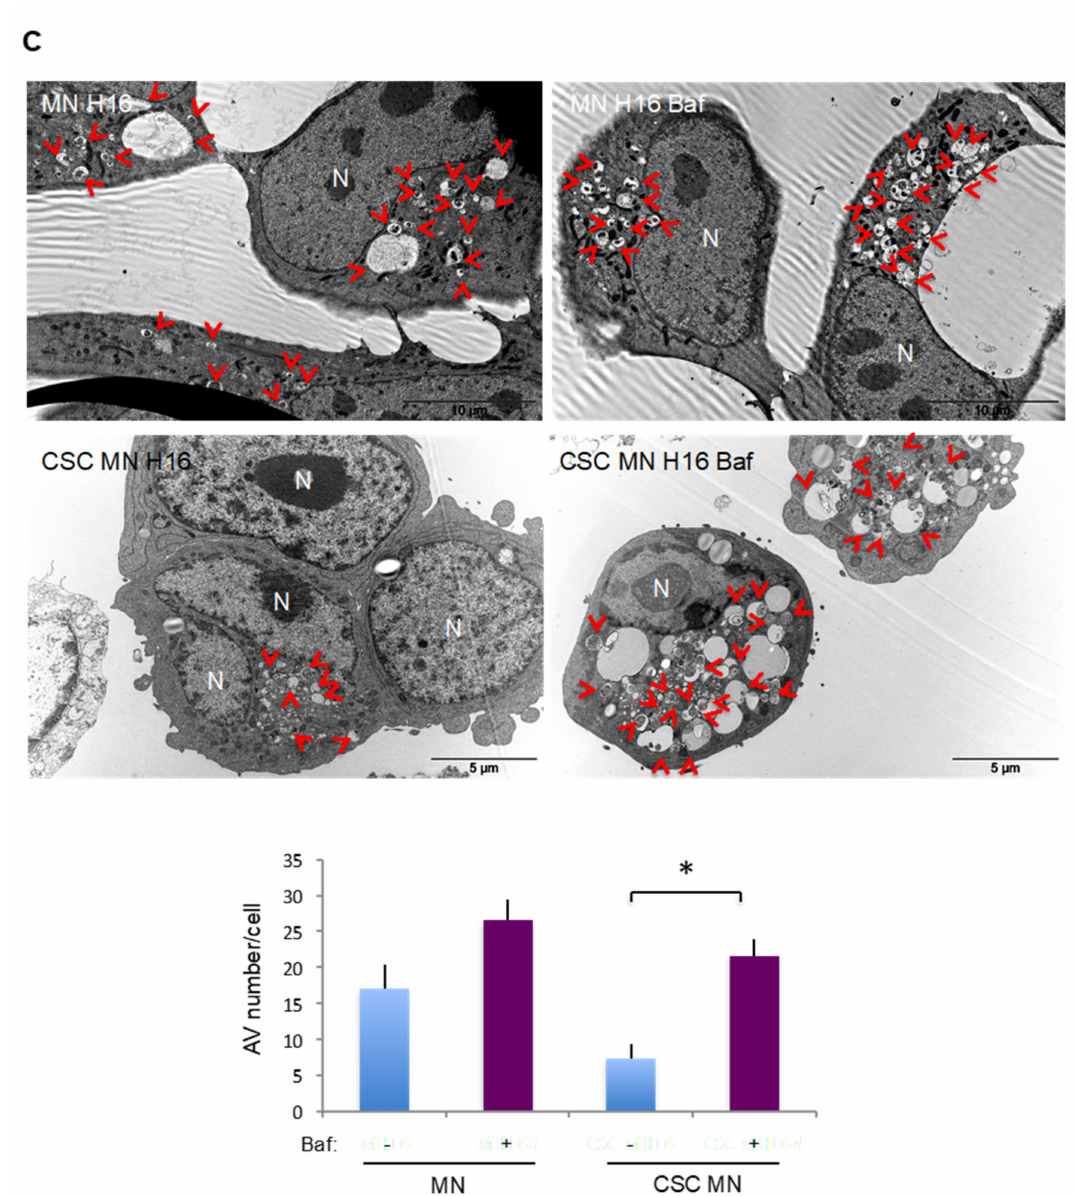
Figure 3. Comparison of basal and stress-induced autophagy in CSC MN-enriched population and MN parental cells. ( A , B ) LC3-II expression was analyzed by Western blot in the MN cell line and in the corresponding CSC-enriched population, in complete medium ( C ) and at 1 (H1), 4 (H4) and 16 (H16) hours after HBSS incubation. One hour prior to protein extraction, Baf was added ( + ) or not ( − ) to block the autophagic flux. LC3-II to β -actin relative expression levels are presented. The results are normalized relative to the control in the absence of Baf. Histograms represent the mean ± SEM of three independent experiments. The dashed line points to the LC3-II level in the control condition ( C ) TEM analysis of the MN cell line and in the corresponding CSC-enriched population after 16 h of HBSS treatment (H16). Histograms represent the mean ± SEM of the number of autophagic vesicles (AV) per cell. Red arrowhead: autophagic vesicle. N: nucleus. NS: not significant. *: p <